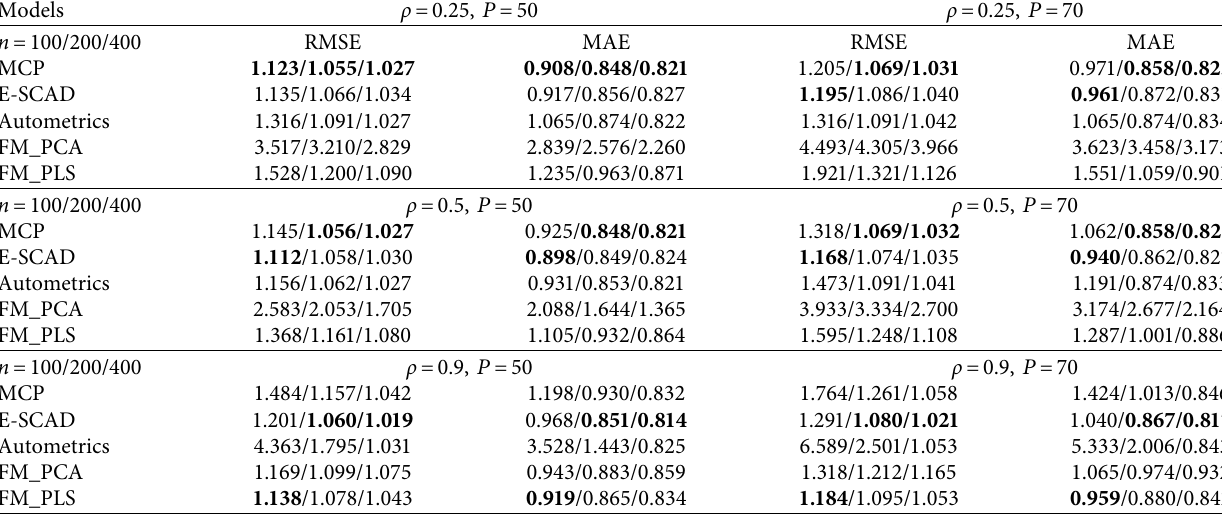
Table 1: Forecast comparison under multicollinearity from Monte Carlo simulation (Scenario 1). Models